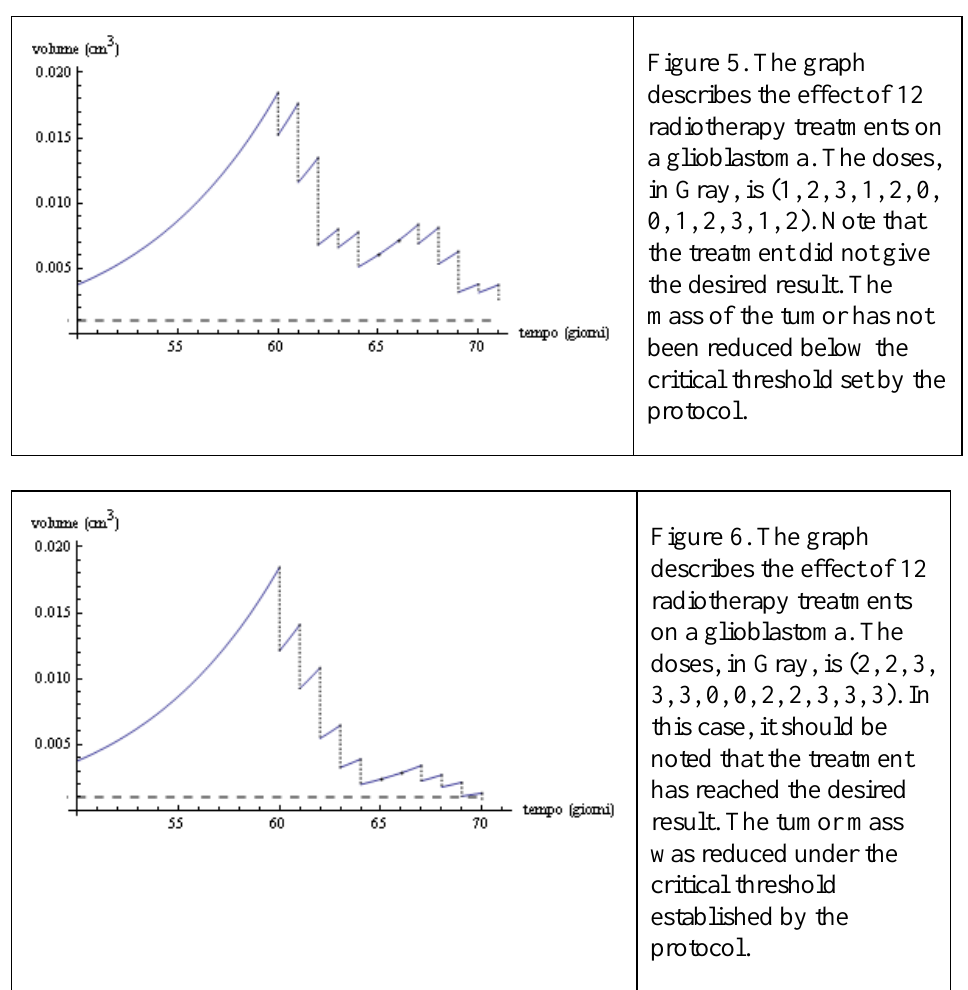
Figure 6. The graph describes the effect of 12 radiotherapy treatments on a glioblastoma. The doses, in Gray, is (2, 2, 3, 3, 3, 0, 0, 2, 2, 3, 3, 3). In this case, it should be noted that the treatment has reached the desired result. The tumor mass was reduced under the critical threshold established by the